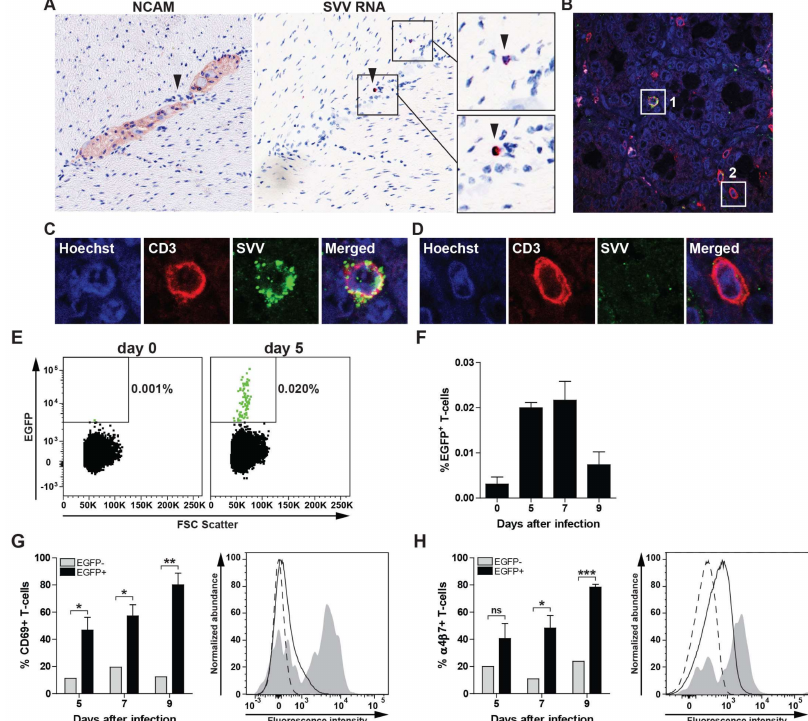
Figure 3. Expression of CD69 and α 4 β 7 integrin on SVV-infected T-cells during acute infection of African green monkeys. ( A ) Consecutive intestine sections from SVV-infected African green monkeys (AGM) at 9 days post infection (dpi) were stained for NCAM by IHC and SVV ORF63 by ISH. SVV-infected cells localized in close vicinity to enteric neurons in the absence of viral RNA expression in neurons. Magnification: 200 × ; Inset: 1000 × . Arrowheads indicate same cell in adjacent sections; ( B – D ) Confocal microscopy image showing co-localization of SVV antigen (green) and CD3 (red) in intestine sections from SVV-infected AGM at 9 dpi. Nuclei were counterstained using Hoechst 33342 (blue). Magnification: 400 × ; ( C , D ) Show enlargements of white boxes indicated with #1 (example of SVV-infected T-cell) and #2 (uninfected